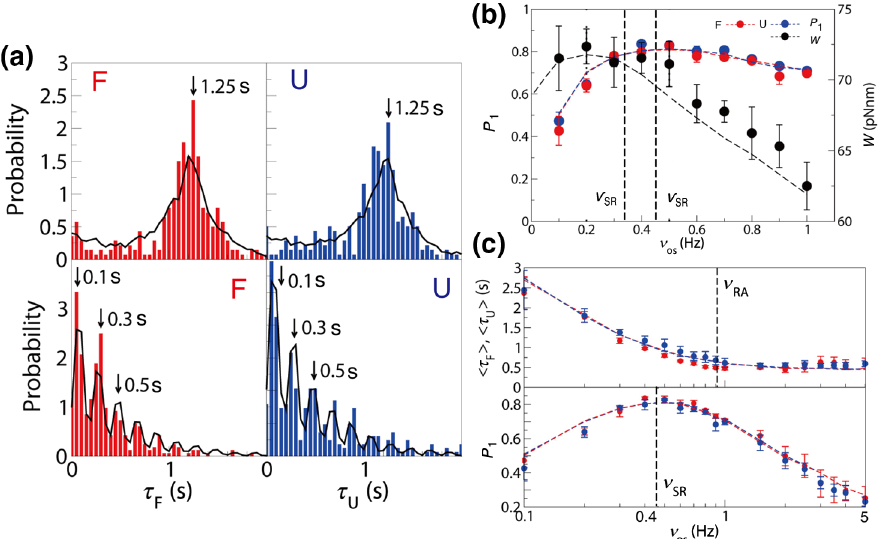
FIG. 4. Other SR quantifiers in hairpin H1. (a) Residence-time distributions for the F (red) and U (blue) states at (cid:2) os ¼ 0 : 4 Hz (upper) and (cid:2) os ¼ 5 Hz (lower). The continuous black lines are the results of the simulations (Sec. IV in Ref. [18]). (b) P 1 in the F (red) and U (blue) and average work W (black) as a function of input frequency. Simulation results are shown by the dashed lines (Sec. IV in Ref. [18]). Vertical dashed lines show the expected resonance frequency. The maximum in P 1 is broad around 0.3–0.6 Hz, while that in W is also broad with a maximum found at a lower frequency in the range 0.1–0.4 Hz. (c) Average residence times (upper panel) and P (lower panel) in the F (red) and U (blue) states as a function of input frequency. Note that the frequency range is larger than that shown in (b). Simulation results are shown as dashed curves (Sec. IV in Ref. [18]). The vertical dashed lines show the two frequencies characteristic of stochastic resonance ( (cid:2) SR ) and resonant activation ( (cid:2) RA ). Statistics: 8 molecules, 3–5-minute traces, and 300–600 hopping transitions at each input frequency. The error bars represent the standard errors over different